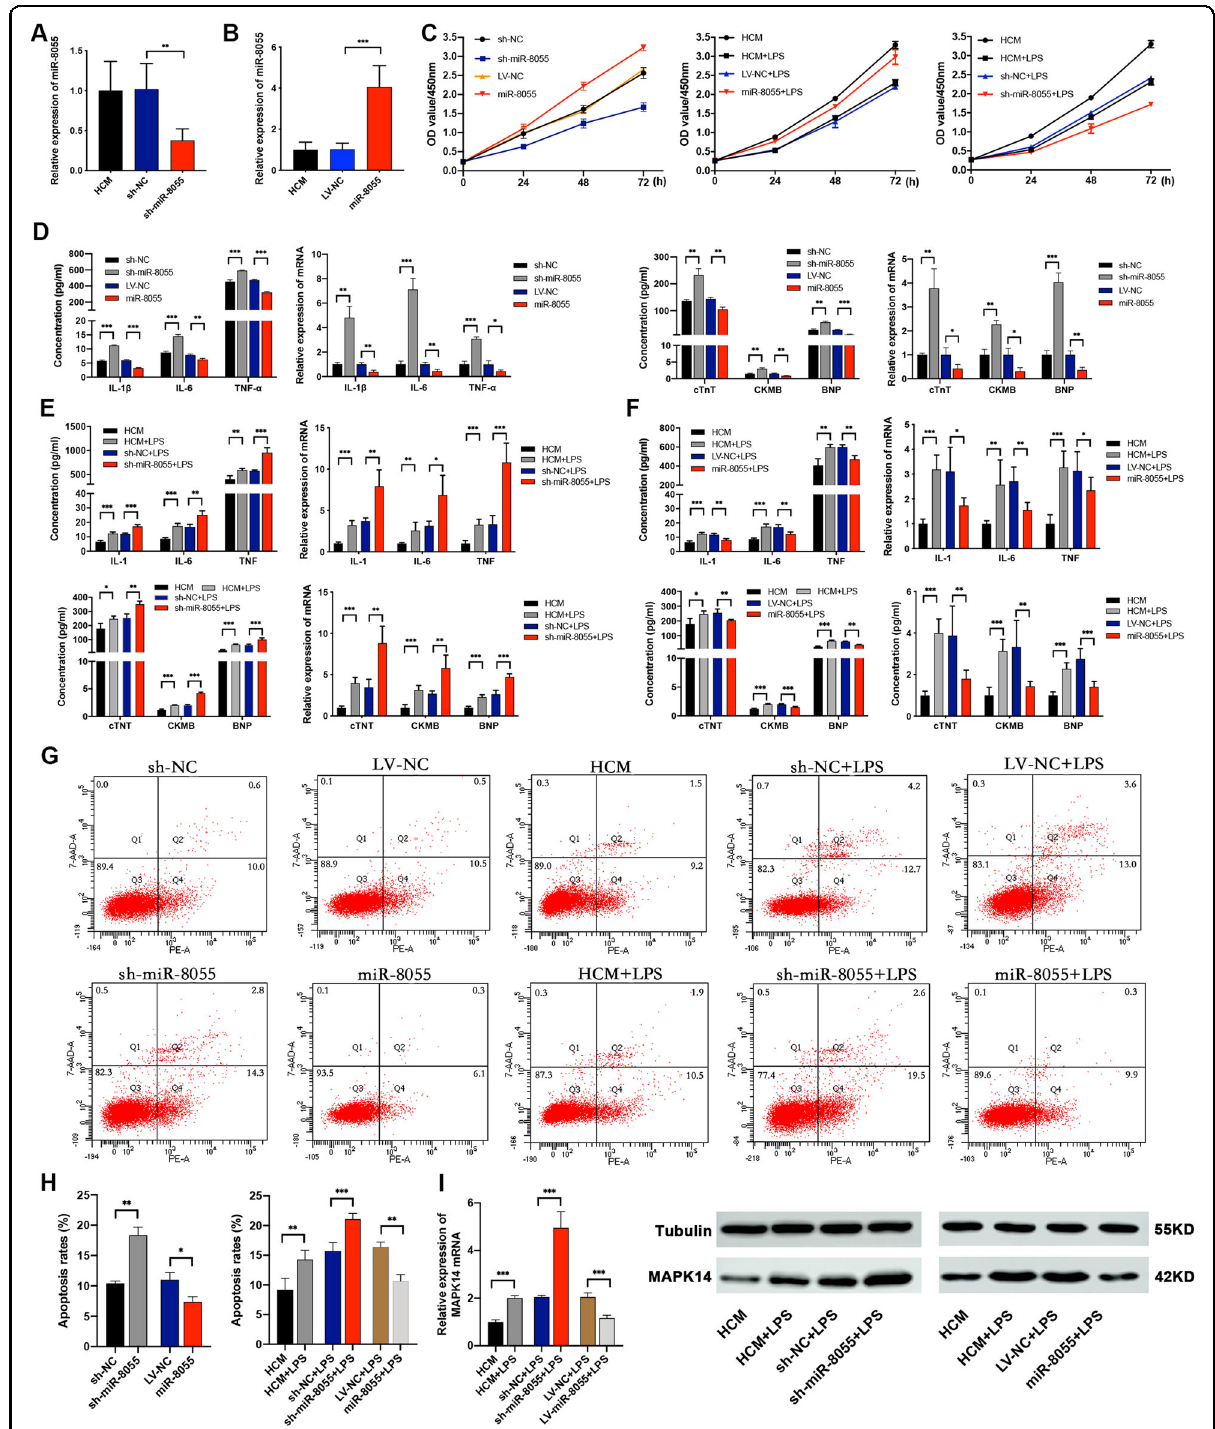
Fig. 5 miR-8055 alleviates in fl ammation, myocardial injury, and apoptosis in HCM. A , B The knockdown or overexpression ef fi ciency of miR- 8055 in HCM cells was detected by qRT-PCR. C Proliferation curves were measured by the CCK-8 assay after knockdown or overexpression of miR- 8055 in HCM cells with or without LPS stimulation. D – F The expression levels of IL-1 β , IL-6, TNF- α , cTnT, CKMB, and BNP in HCM with miR-8055 knockdown or overexpression were detected by qRT-PCR and ELISA. D , cells without LPS stimulation; E , F , cells with LPS stimulation. G , H Cell apoptosis was detected with annexin V-FITC/7AAD double staining using fl ow cytometry apoptosis assay. I qRT-PCR and WB results showed the mRNA and protein levels of MAPK14 in HCM with miR-8055 knockdown or overexpression. Data are presented as mean ±SD ( n = 3 biologically independent samples). * p < 0.05; ** p < 0.01; *** p < 0.001 (Student ’ s t